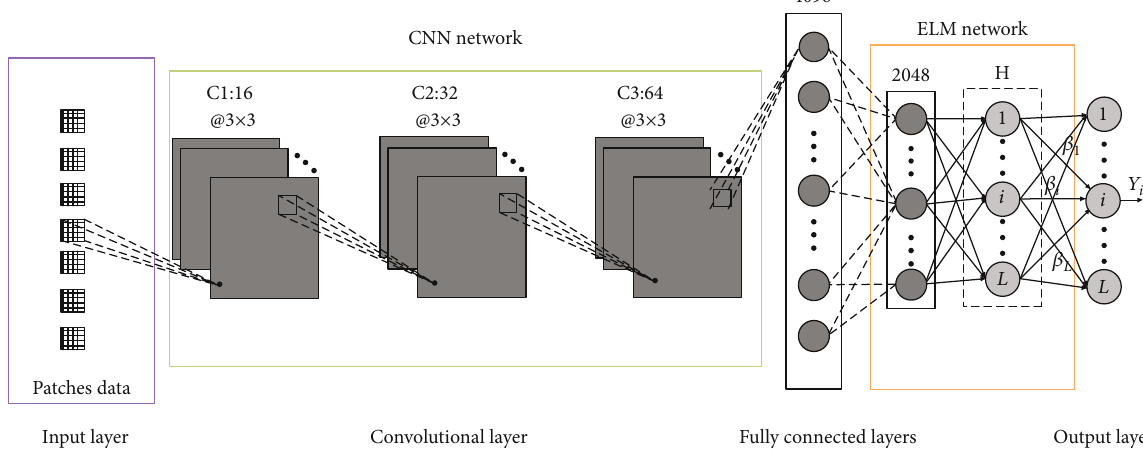
Figure 1: Convolution ELM network. The input layer is a small data set that provides data input for the CNN network. The last layer of the CNN network ’ s fully connected layer provides data input for the ELM